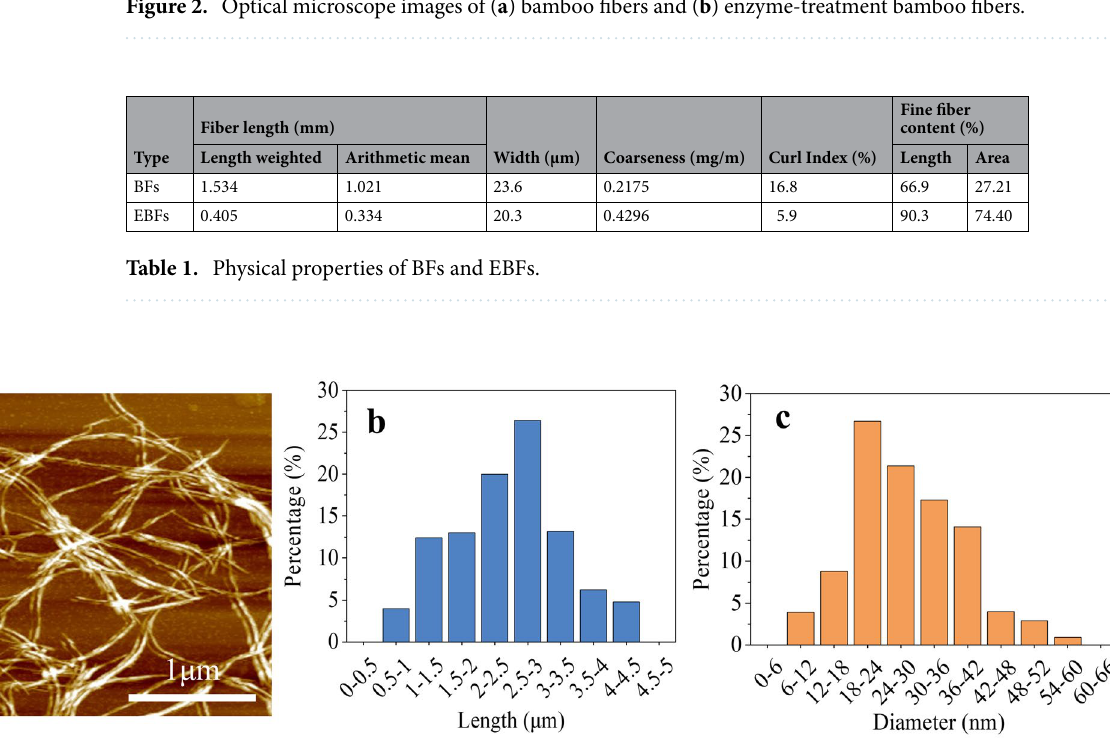
Figure 2. Optical microscope images of ( a ) bamboo fibers and ( b ) enzyme-treatment bamboo fibers.